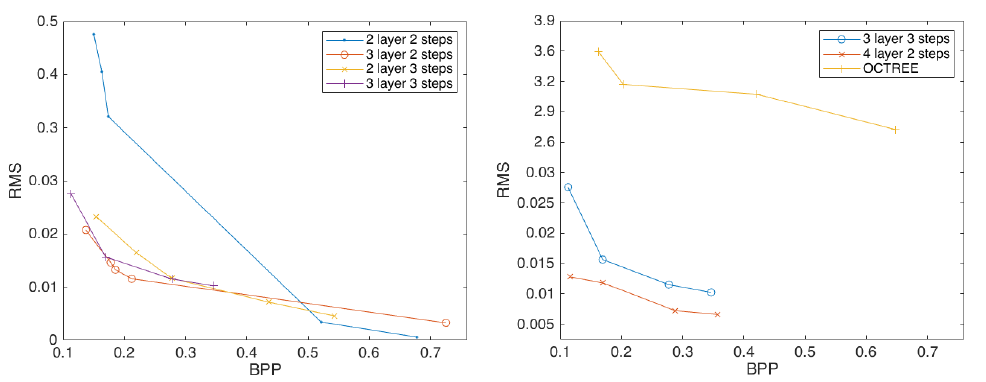
Figure 7. Comparison of stride effects of each layer ( left ); curve comparison for best results ( right